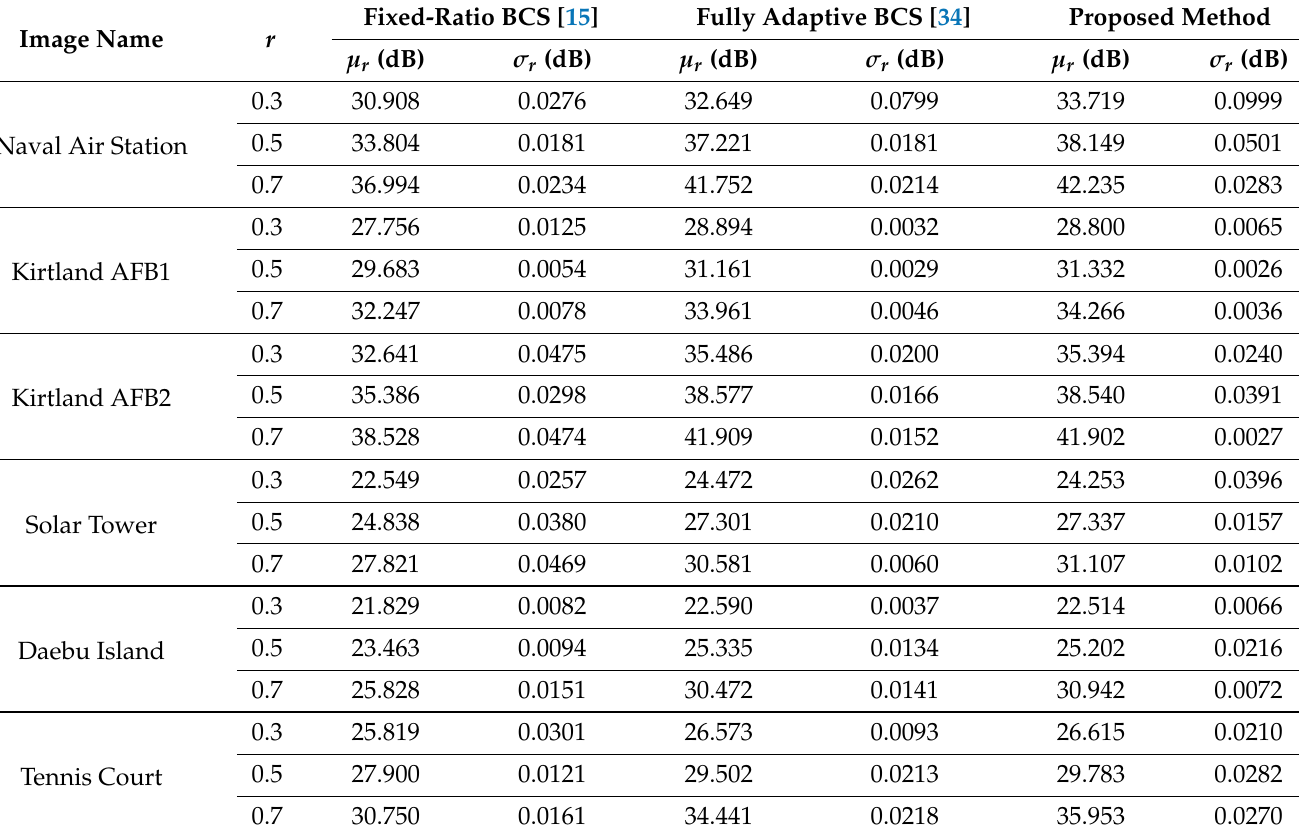
Table 3. Mean ( µ r ) and standard deviation ( σ r ) of PSNR for various BCS reconstruction